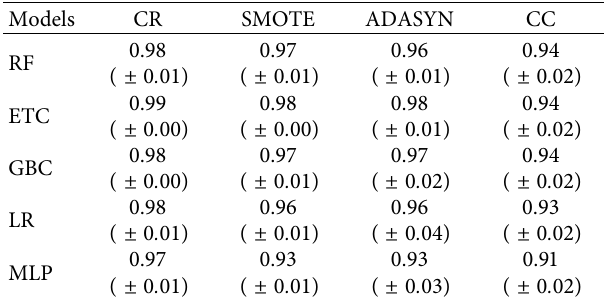
Table 16: Results of 10-fold cross-validation. Table 17: Performance comparison with previous studies.